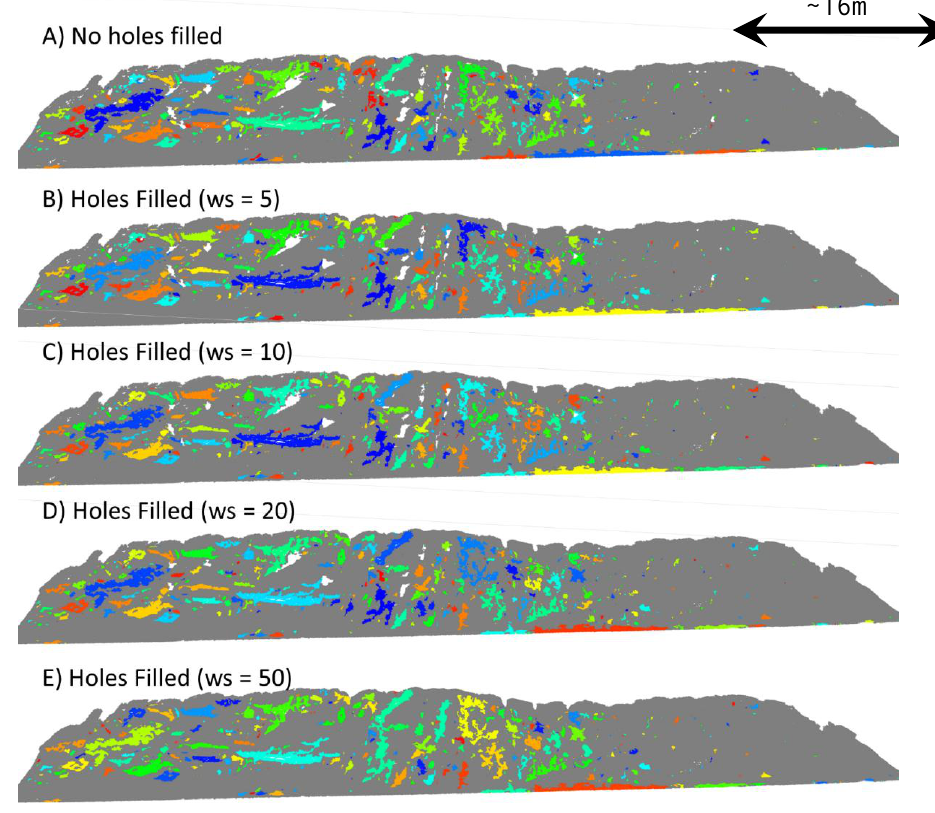
Figure 14. Evaluation of the influence of varying the hole filling window size (ws) on the resulting rockfall clusters (2013–2014) . Note that the figure uses the same coloring scheme as described in Figure 9 with grey representing areas of no significant erosion and white indicating holes in the dataset . For reference, this section is 110 m long. ( A ) no holes filled; ( B ) holes filled (ws = 5); ( C ) holes filled (ws = 10); ( D ) holes filled (ws = 20); ( E ) holes filled (ws =